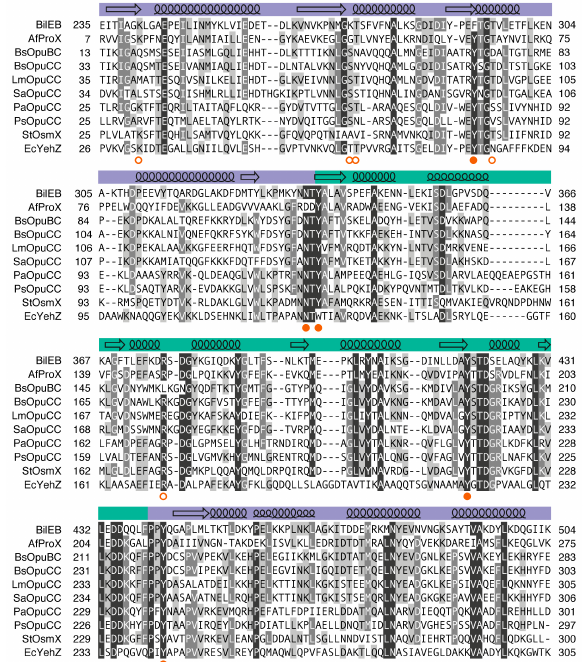
Figure 2. Multiple sequence alignment of BilEB and selected substrate-binding protein homologs. For a full list of organism names and protein accession numbers, see Table A1. The alignment has been truncated at the N-terminus to exclude signal sequences and residues not visible in the crystallographic structures. Sequences are numbered according to the unprocessed form of the protein, unless this varies from numbering used in published studies in which case the numbering is consistent with the literature. Residues are shaded according to percentage sequence identity. The secondary structure of BilEB SBD is indicated above the alignment. Domain A is indicated in purple, domain B in green. Arrows indicate β -sheets; large loops indicate α -helices, small loops indicate 3 10 -helices (secondary structure assigned by DSSP [47]). Orange symbols below the alignment indicate amino acid residues involved in substrate binding either through caging the quaternary ammonium (closed circles) or forming salt bridges or hydrogen bonds (open